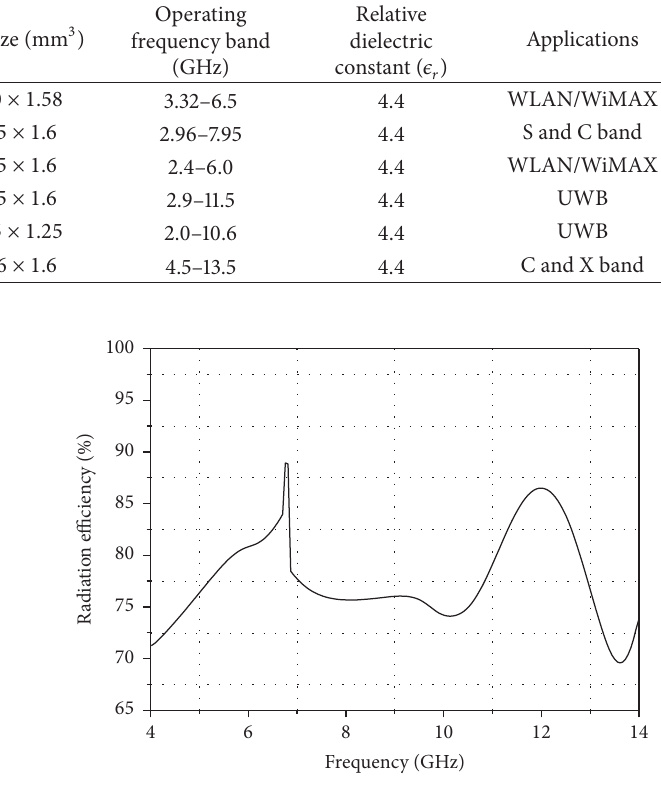
Figure 17: Gain for the proposed defected substrate wideband antenna.